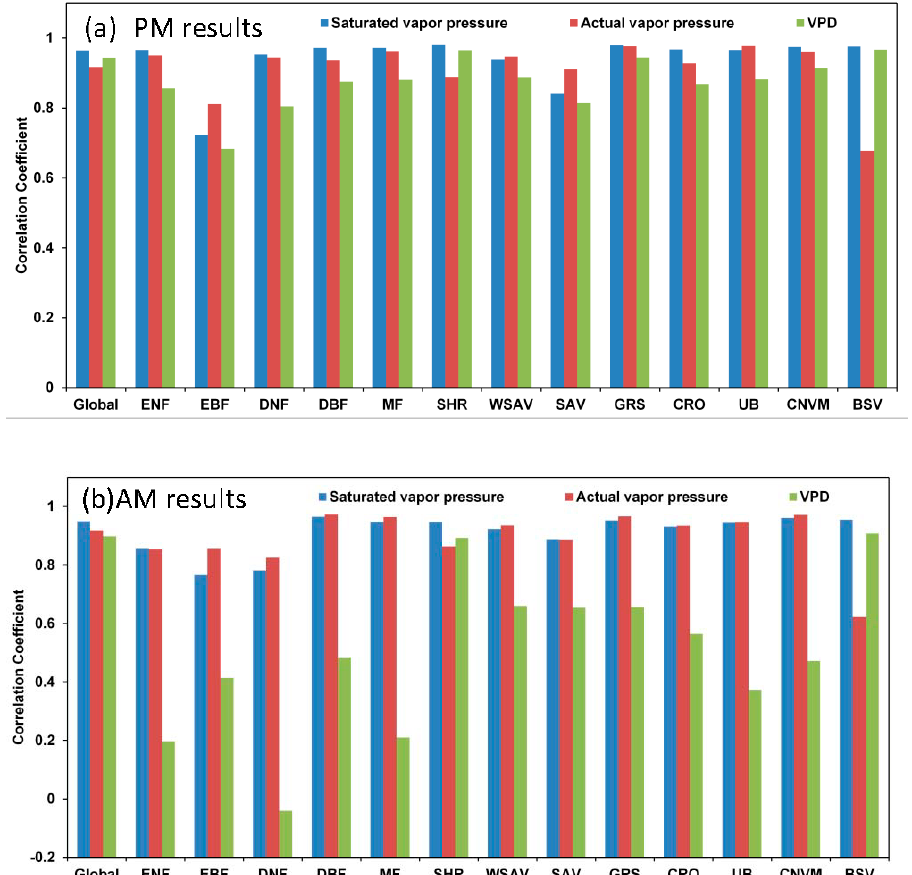
Figure 7. Correlations between the Modern-Era Retrospective analysis for Research and Applications, Version 2 (MERRA-2) ( a ) p.m. and ( b ) a.m. predictions and Integrated Surface Global Hourly (ISH) station observations of saturation vapor pressure ( (cid:1857) (cid:3046) ) ,actual vapor pressure ( (cid:1857) (cid:3028) ), and Vapor Pressure